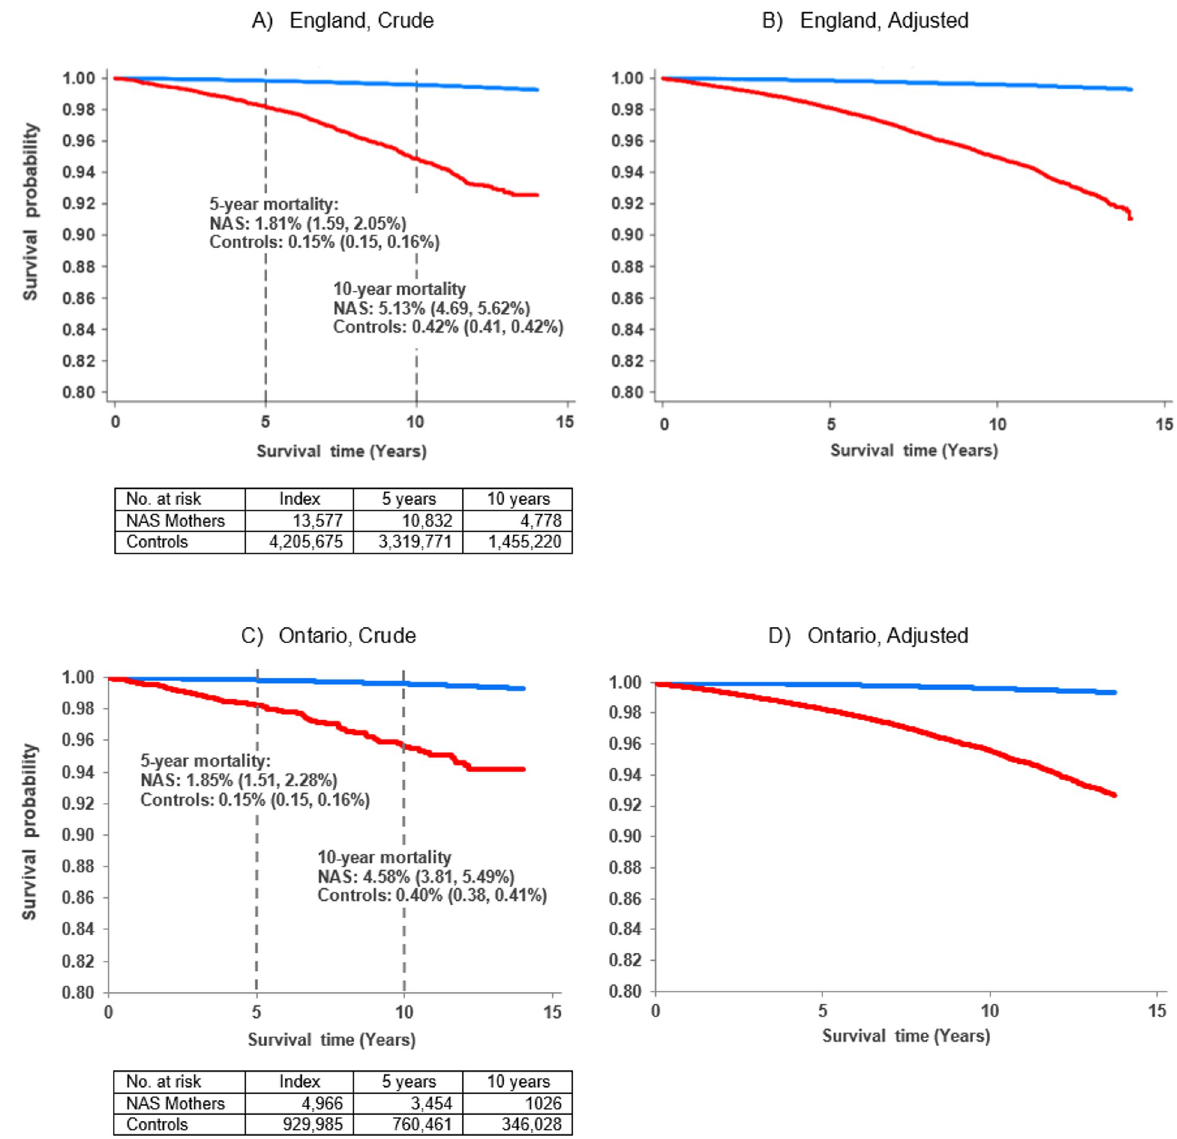
Fig 1. Survival curves for all-cause mortality—Crude (Kaplan–Meier curve) and adjusted (derived from Cox model) for maternal age at delivery, 2002 to 2016. Crude curves for England (A) and Ontario (C); adjusted curves for England (B) and Ontario (D). Red, neonatal abstinence syndrome (NAS) mothers; blue, controls. The adjusted survival curve for the England controls is a 10% sample of the full control population. p < 0.001 for a difference in all-cause mortality between NAS mothers and controls for the overall study period (crude and adjusted), 5-year mortality (crude), and 10-year mortality (crude) for England and Ontario. Mortality rates superimposed on figures are accompanied by 95% confidence limits presented in